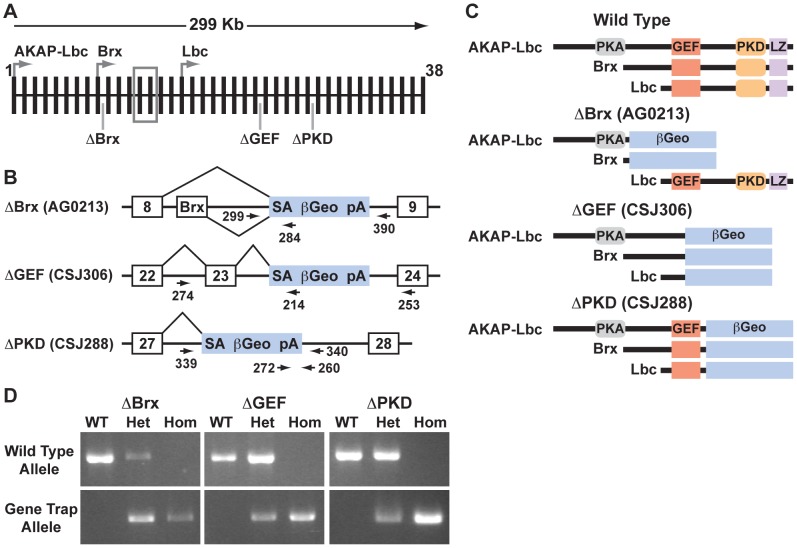
Gene-traps disrupt AKAP13 in multiple locations.(A) Schematic of the AKAP13 genomic locus. Exons are depicted with black bars, cassette exons with a grey box, and alternative promoters with arrows. The three gene-trap insertions are indicated. (B) Diagram of the gene-trap constructs (blue boxes) integrated between AKAP13 exons (open boxes with exon numbers). The gene-trap vector contains a strong splice acceptor (SA), βGeo cassette (β−galactosidase and neomyocin resistance genes), and stop codon, as well as a polyadenylation (pA) sequence. The splicing events indicated were confirmed by RT-PCR and sequencing. Primers used to genotype the wild-type and gene-trap alleles are shown (black arrows). (C) Resulting protein fusions of AKAP-Lbc, Brx, and Lbc isoforms with βGeo for the gene-trap mutational series. PKA = protein kinase A binding domain, GEF = Rho-guanine nucleotide exchange factor domain, PKD = protein kinase D binding domain, LZ = leucine zipper domain. (D) Sample genotyping of mouse tail clips for the AKAP13 gene-trap mutations using primers in (B). WT = Wild-type, Het = Heterozygote, Hom = Homozygote.